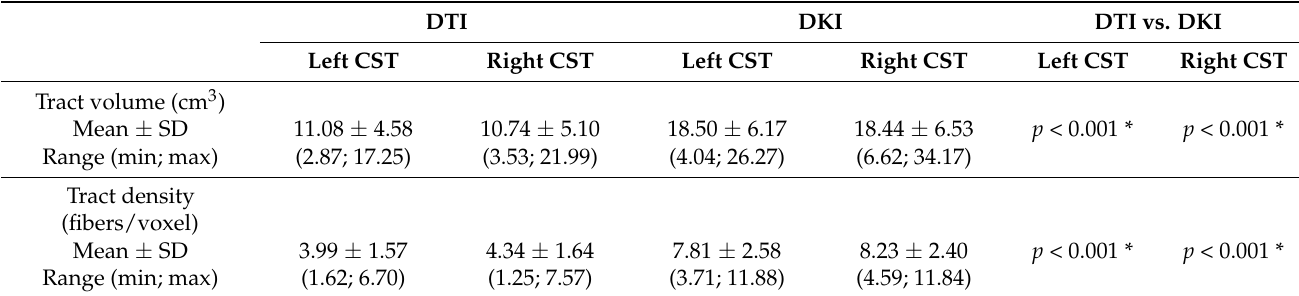
Table 2. Results of fiber tractography of the CST in